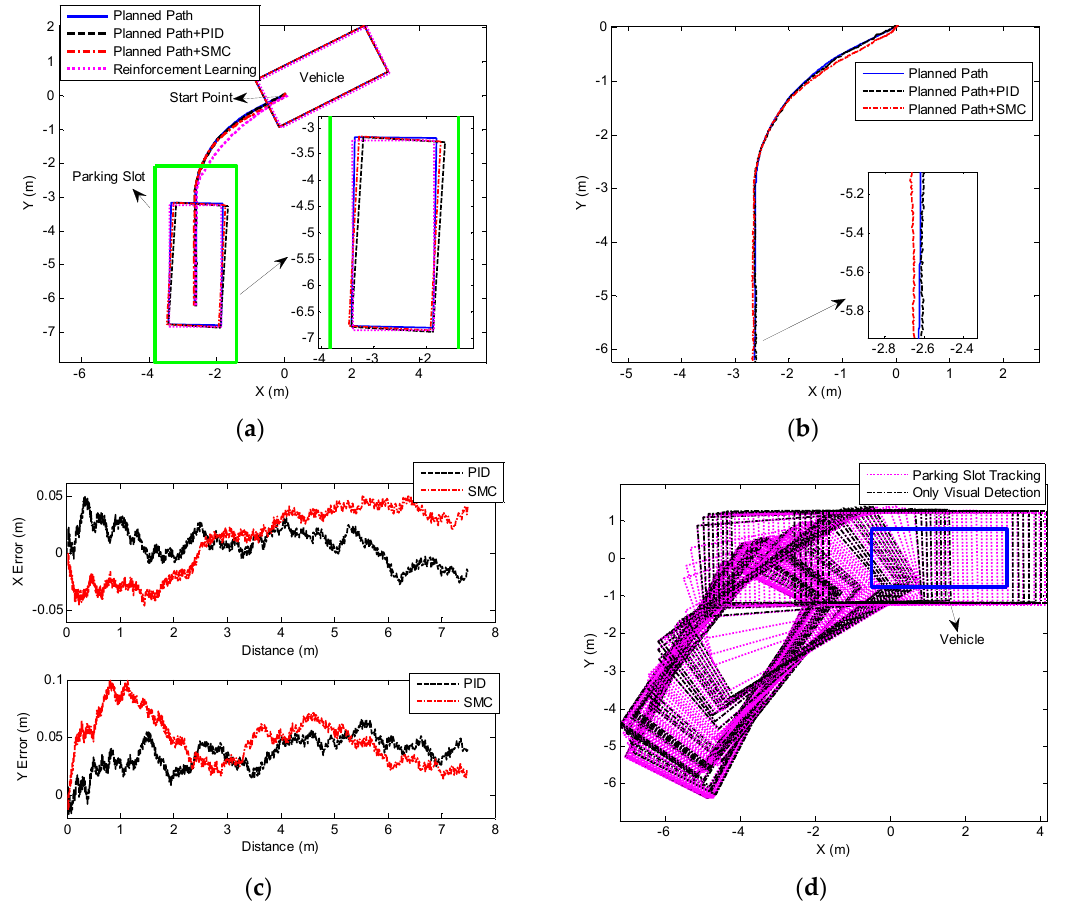
Figure 20. Experimental results of 60° perpendicular parking. ( a ) Parking performance of different methods; ( b ) and ( c ) present the control effect and error of different path tracking methods, respectively. ( d ) Parking slot detection and tracking in the parking process. Table 1. Experimental data of 60° perpendicular parking.